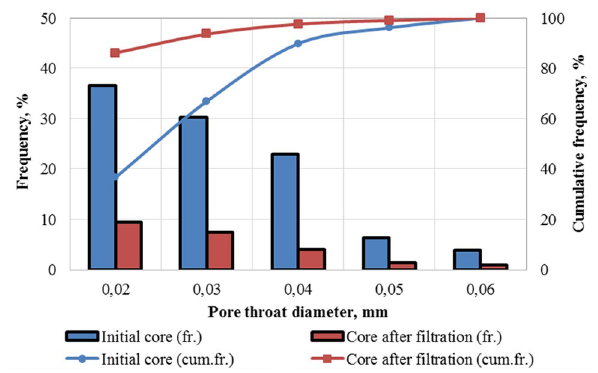
Fig. 6 Distribution of pore throats by diameter before and after filtra- tion